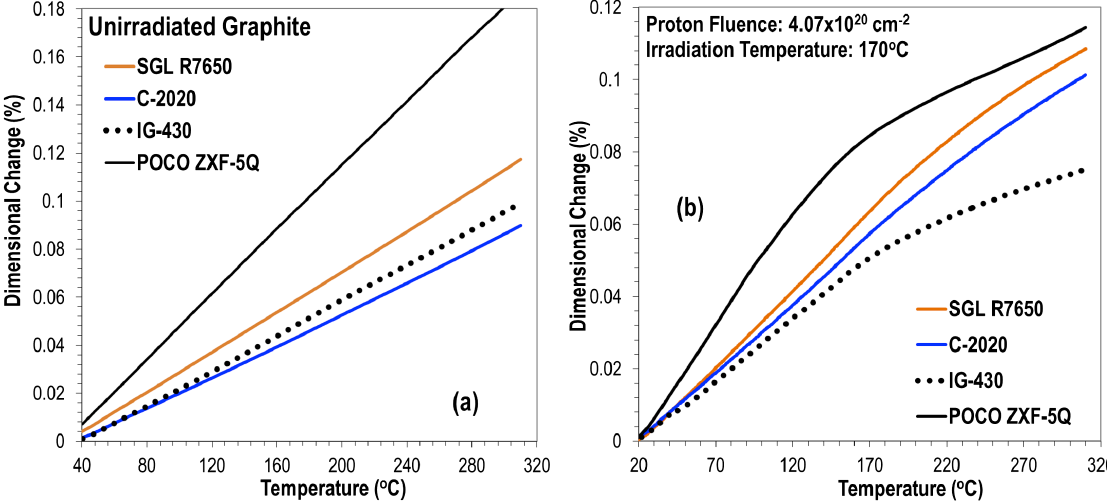
FIG. 8. Dimensional changes in as-received, unirradiated graphite grades (a) and following irradiation to the fluence of 4 . 07 × 10 20 p = cm 2 at 170 °C. Heating rate of 2 °C = minute was used.